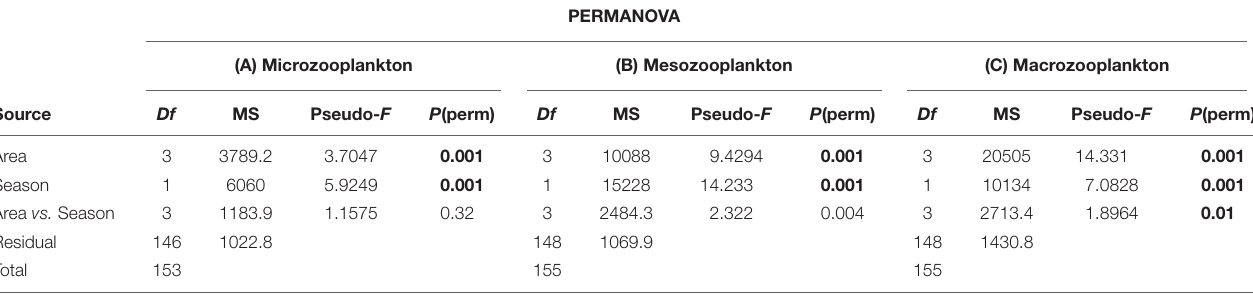
FIGURE 6 | (A–C) MDS ordination of the micro-, meso- and macrozooplankton (respectively) in response to the area (Coastal-red asterisks; Inner Shelf-Yellow squares; Shelf Break-Green triangles; and Slope-Blue circles). (D–F) MDS ordination of the micro-, meso- and macrozooplankton (respectively) in response to seasonality (dry season-red asterisks; and rainy season-empty blue circles). TABLE 3 | Summary: PERMANOVA, this analysis tests differences in quantitative taxonomic composition of the micro- meso- and macrozooplankton community considering area and season as